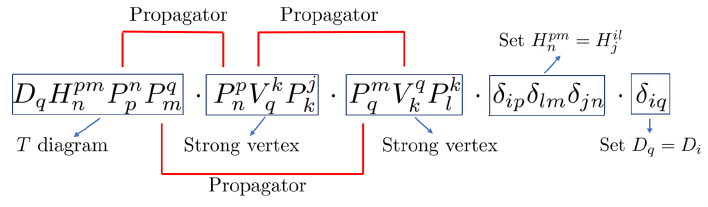
, P i , V k , P j , P k ) at hadron level. i i l l k